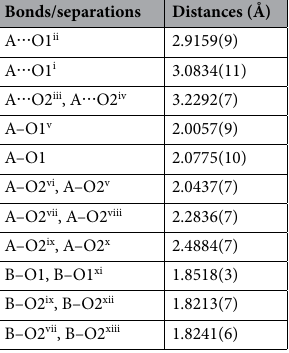
Table 5. Selected interatomic distances. Symmetry codes for equivalent atoms: (i) x , y – 1, z; (ii) – x – ½, y – ½, z ; (iii) – x + 1, – y , z + ½; (iv) – x + 1, – y , – z ; (v) – x + ½, y – ½, z ; (vi) – x + ½, y – ½, – z + ½; (vii) x – 1, y , z ; (viii) x – 1, y , – z + ½; (ix) x – ½, – y + ½, – z ; (x) x – ½, – y + ½, z + ½; (xi) – x , – y + 1, – z ; (xii) – x + ½; y + ½, z ; (xiii) – x + 1, – y + 1, – z .